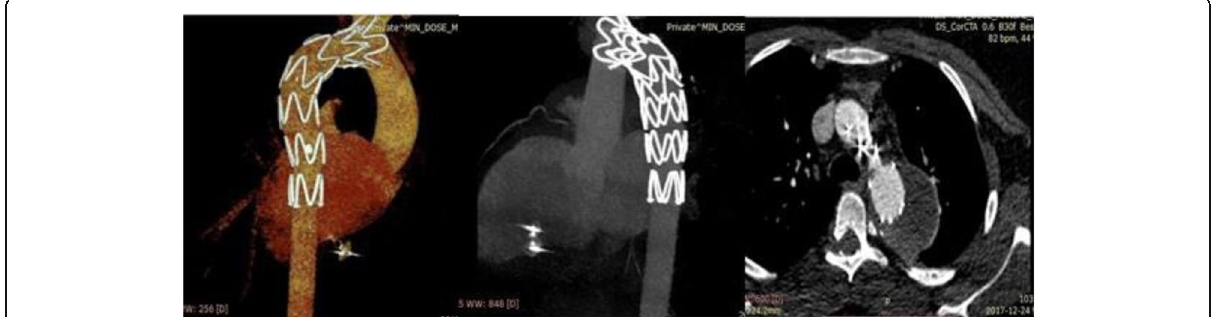
Fig. 6 Follow-up CT angiography showing complete exclusion of the